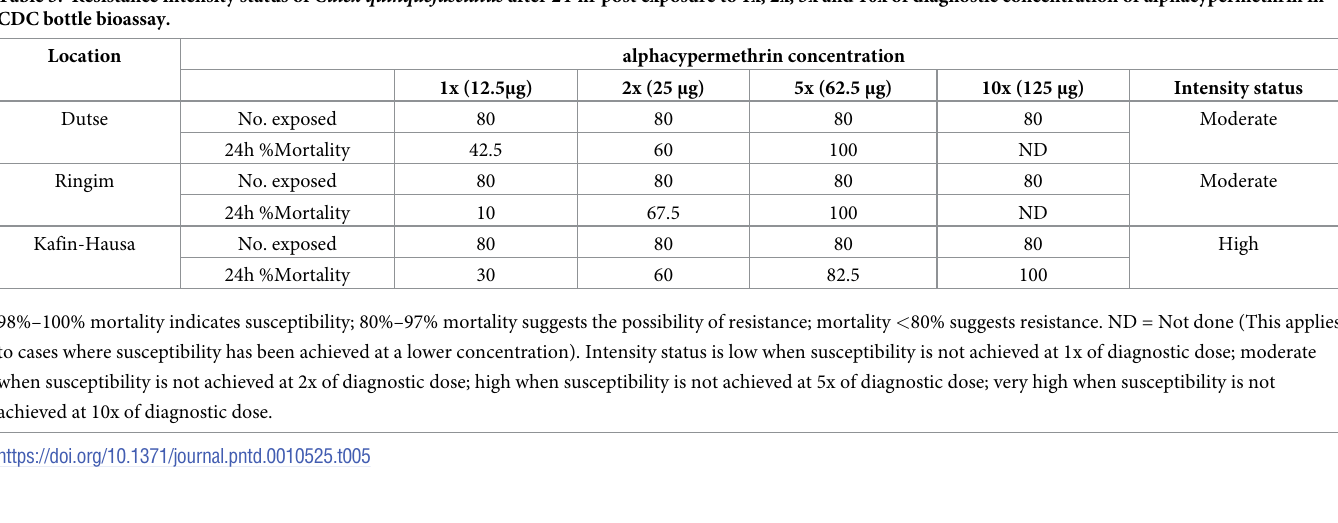
Table 4. Resistance intensity status of Culex quinquefasciatus after 24-hr post exposure to 1x, 2x, 5x and 10x of diagnostic concentration of lambda-cyhalothrin in CDC bottle bioassay. Location Dutse No. exposed Ringim No. exposed Kafin-Hausa No. exposed